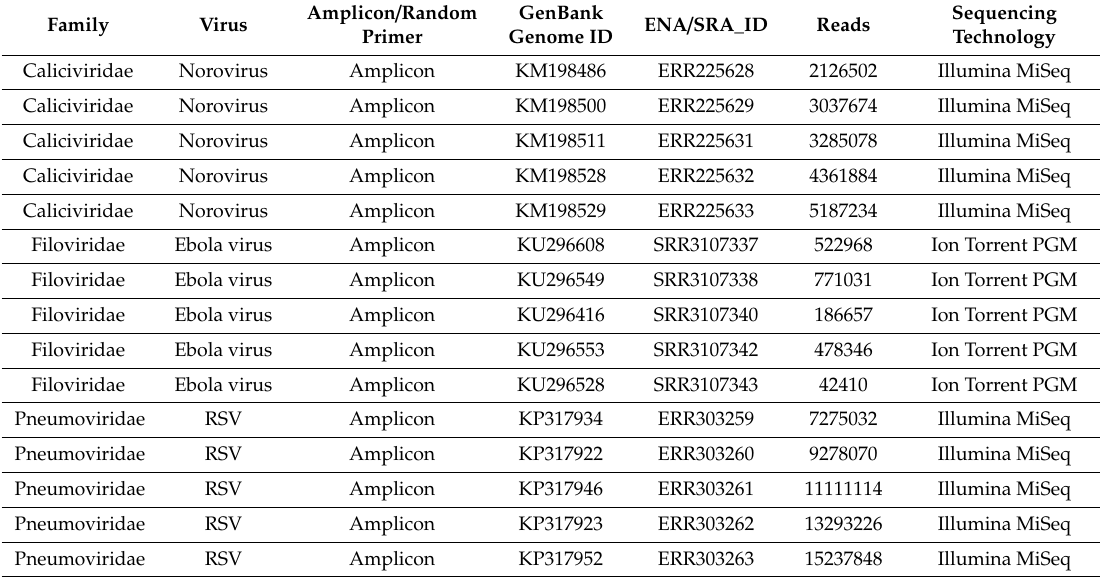
Table 3. Real short reads data. Rows contain information for each real reads’ dataset (i.e., virus family, virus, genome strain GenBank ID, SRA project ID, number of reads and technology used to sequence data). SRA: Sequence Read Archive; ENA: European Nucleotide Archive.